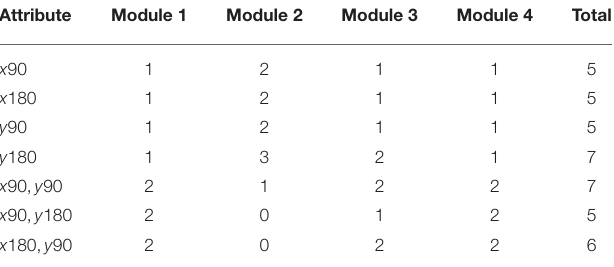
TABLE 2 | The skill(s) measured by the number of questions across four modules. Attribute Module 1